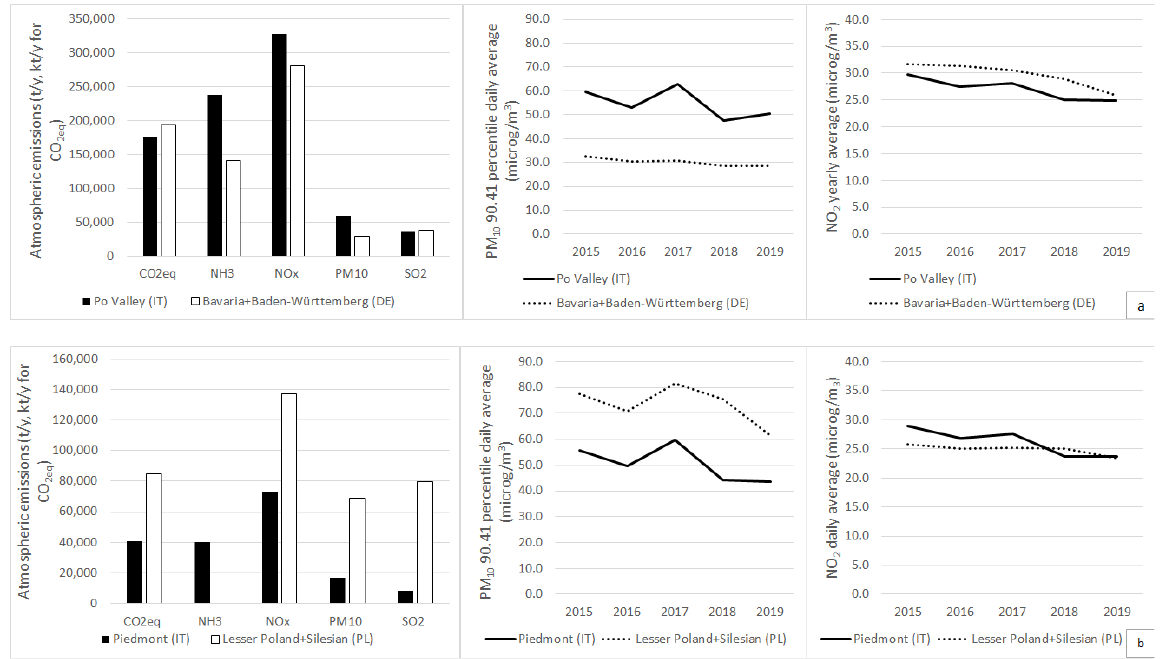
Figure 3. ( a ) Emission inventory for Po Valley (Piedmont + Lombardy + Emilia Romagna + Veneto) in Italy and Southern Germany (Bavaria + Baden-Württemberg); ( b ) emission inventory for Piedmont in Italy and Southern Poland (Lesser Poland and Silesian). Yearly NO 2 concentrations and PM 10 90.41 percentile daily average are reported for the period 2015–2019.